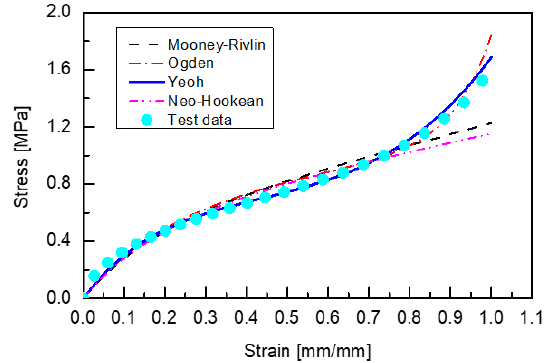
Figure 3. Stress – strain curves of the hyperelastic model.